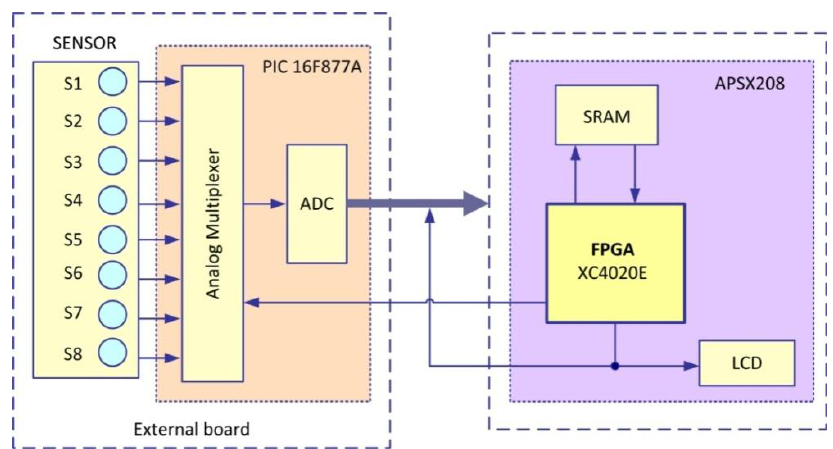
Figure 13. The gas identification module platform.